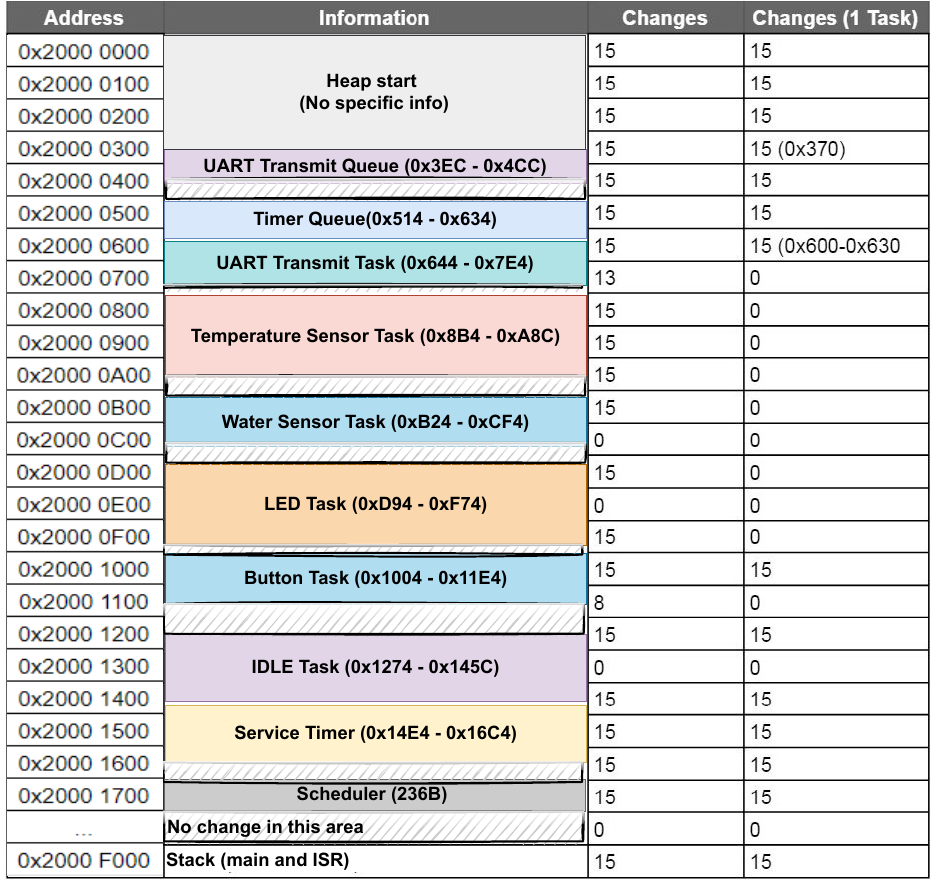
Figure 14. SRAM0 memory map with amount of changes between 16 memory